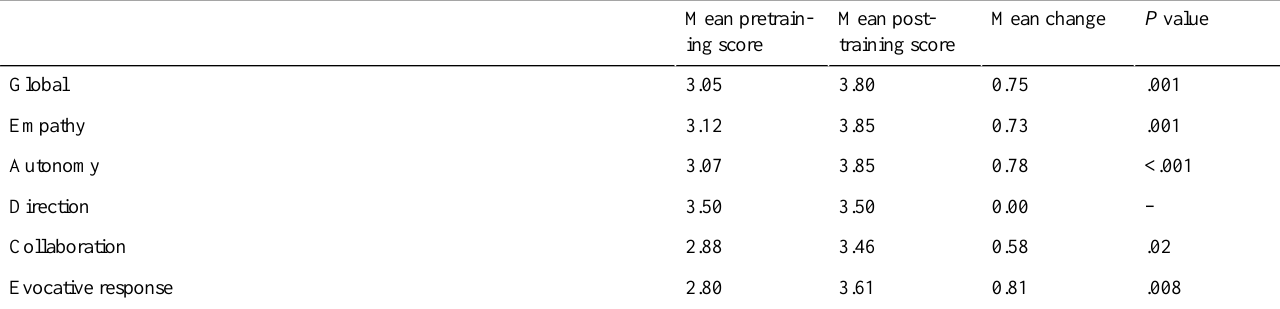
Table 2. Mean pre- to post-training change in global scores for proficiency in motivational interviewing (N = 13 for each component)